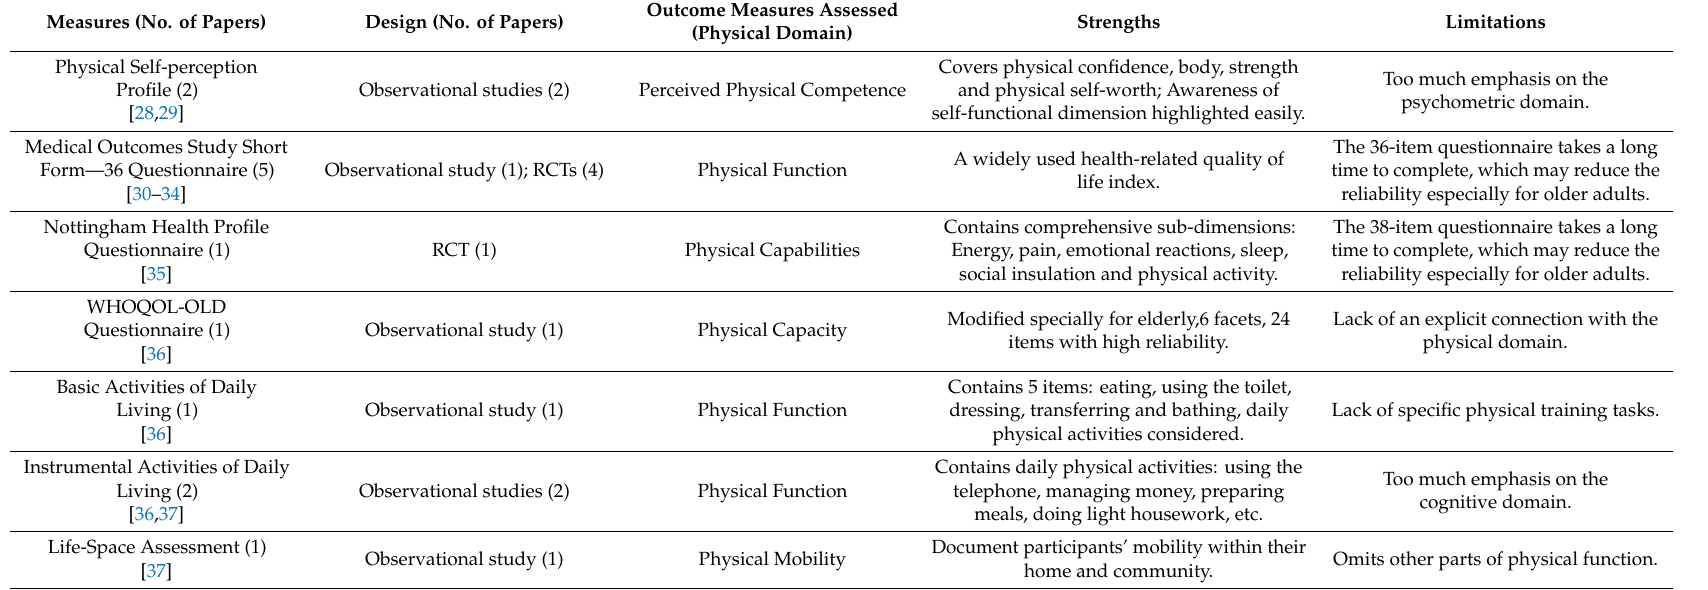
Table 4. Critical analysis of self-reported measures of physical competence within physical literacy for older